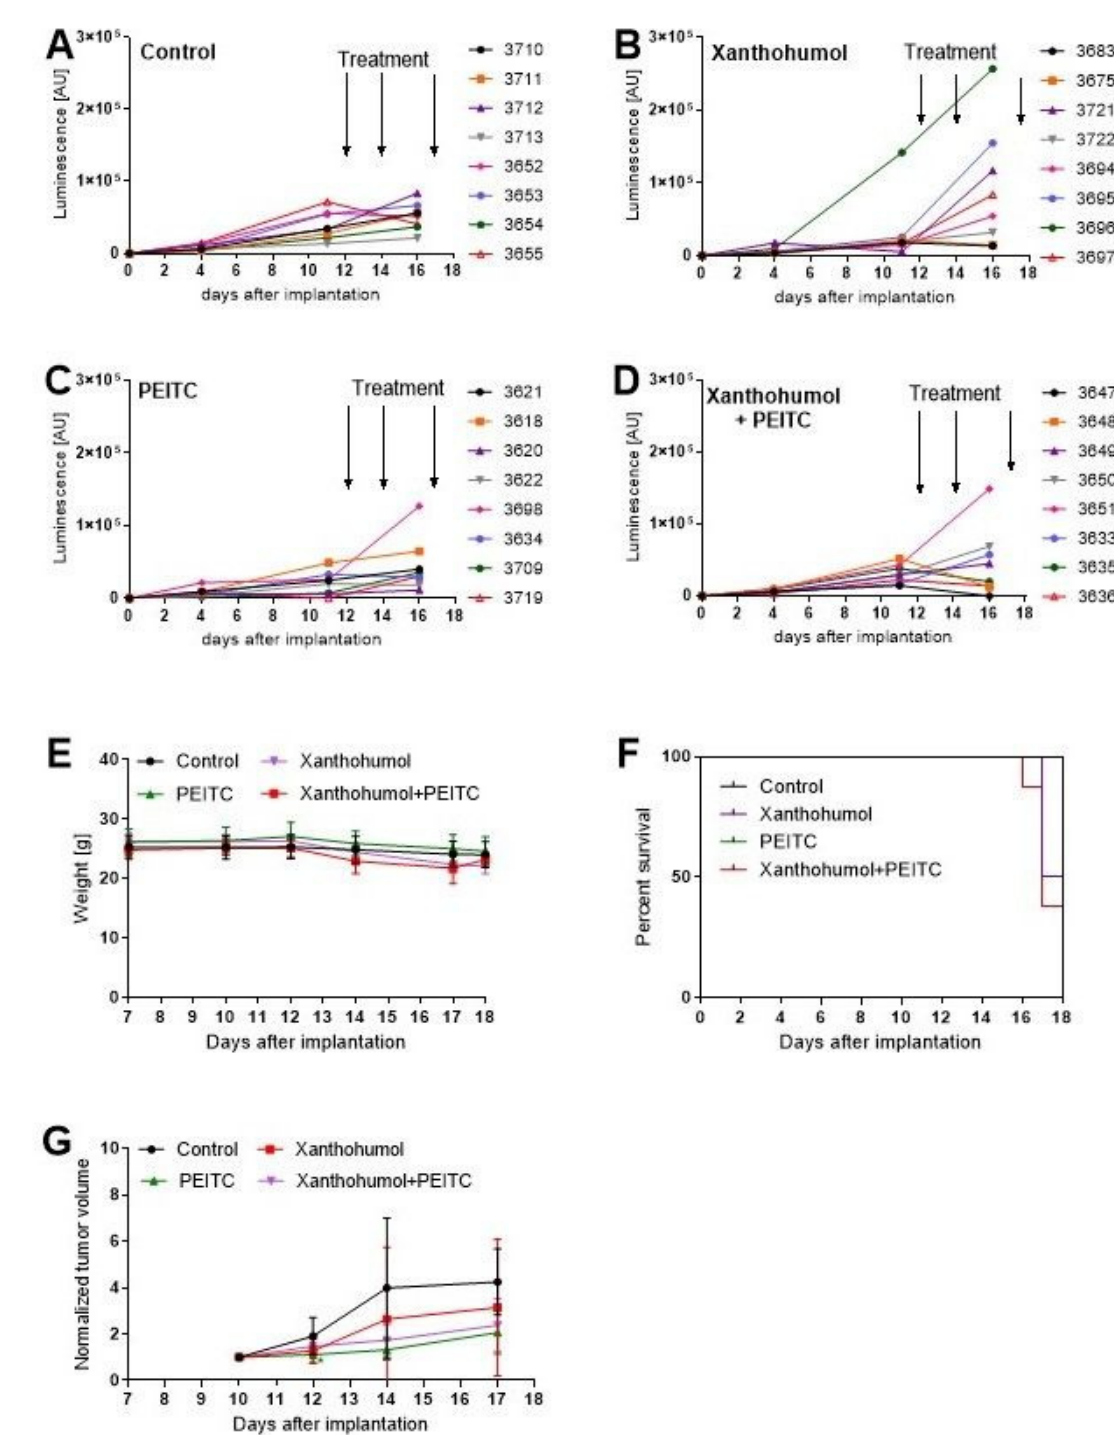
Figure 14. The in vivo efficacy and toxicity of single compounds and combination. Panels ( A – D ) present the luminescence of tumors, measured at day 4, 11, and 16 after implantation; panel ( E ) present the changes in mice weight during the experiments; Panel ( F ) presents the survival using the Kaplan–Meier curve; panel ( G ) presents the normalized tumor volume; tumor volume was measured using the formula V = 0.5 × W 2 × L, where W and L mean width, and length, respectively. Tumor size was measured using a caliper. Statistical analysis was performed using GraphPad version 8.00 (GraphPad Software, San Diego, CA, USA). The data are shown as the means ± SD. The statistical significance was analyzed using one-way ANOVA with post-hoc Dunnett’s test. A p -value less than 0.05 was considered significant.